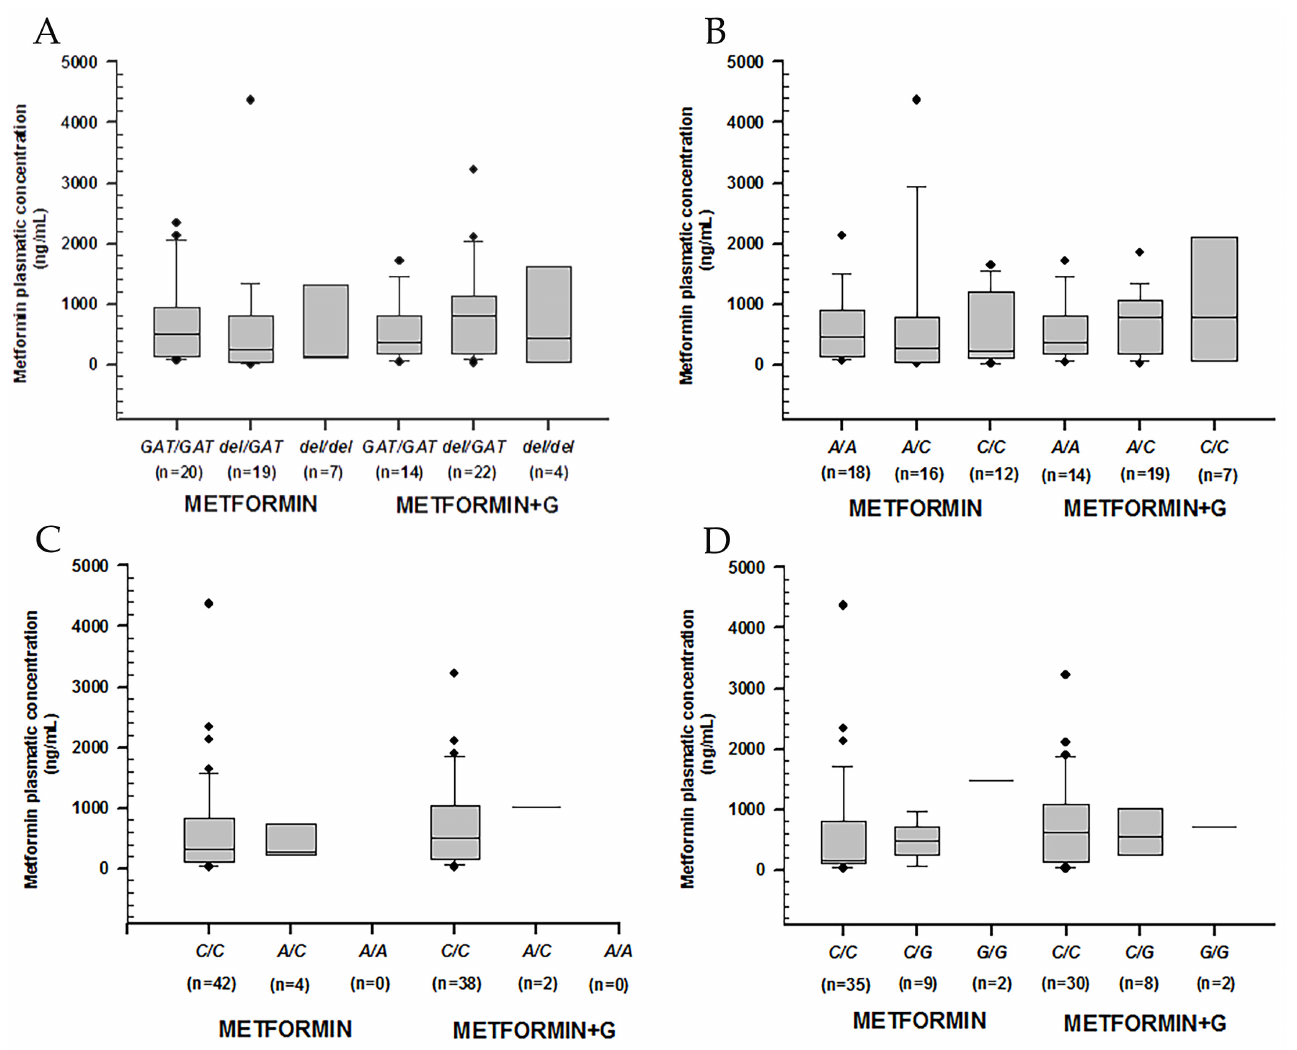
Figure 1. Metformin plasmatic concentration boxplots (ng/mL), including medians, interquartile ranges, and outliers (filled circles). ( A ) rs72552763 (OCT1). ( B ) rs622342 (OCT1). ( C ) rs316019 (OCT2). ( D ) rs2076828 (OCT3). Data are sorted according to genotype and treatment type (metformin to the left, metformin + glibenclamide to the right). No statistical difference was found. Higher metformin concentrations were observed among non-controlled patients car- rying rs1128503 in C/T ( p = 0.011), rs2032582 in G/T ( p = 0.041), and rs1045642 in C/T ( p = 0.002). Among controlled patients, we found the lowest metformin concentration by rs1045642 in C/T ( p = 0.014) (Table 4) (Figure 2).